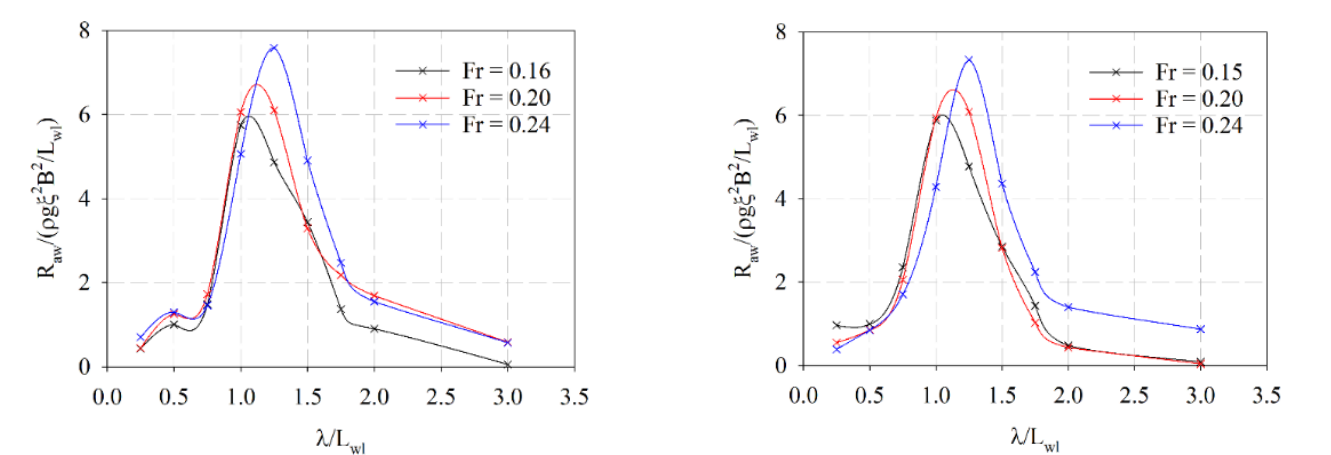
Figure 9. Dimensionless added wave resistance versus different wavelengths in head waves. ( Right ) Load Condition 1. ( Left ) Load Condition 2. Source: Own elaboration.